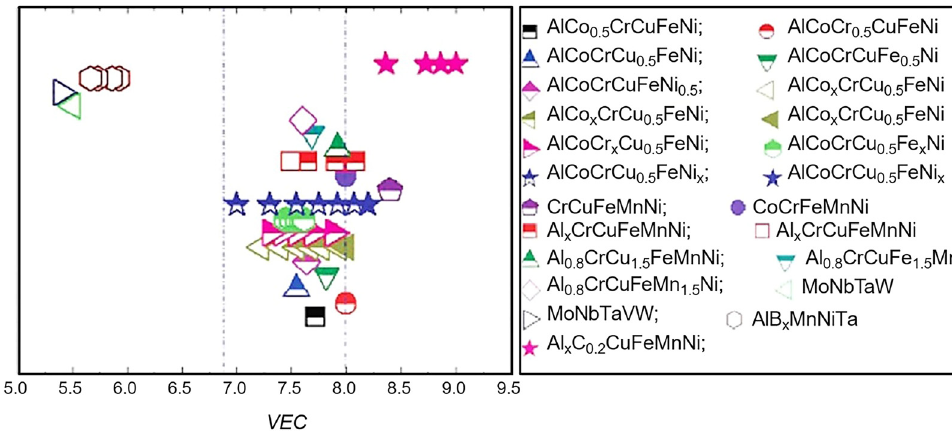
Figure 2: Relationship between VEC and solid solution stability of HEAs [ 76 ]